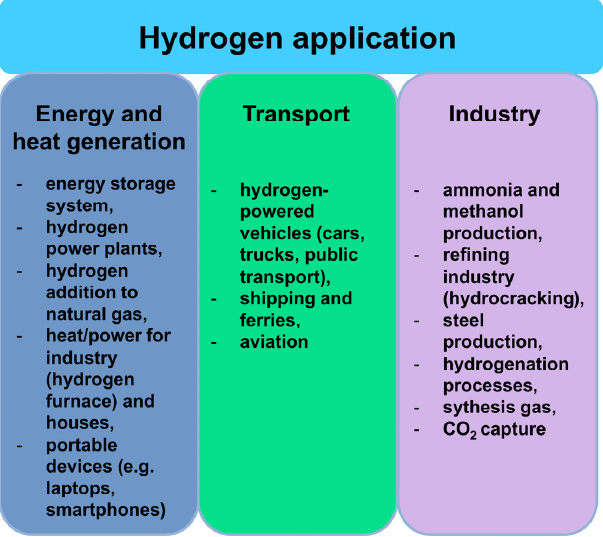
Figure 1. Current and future hydrogen